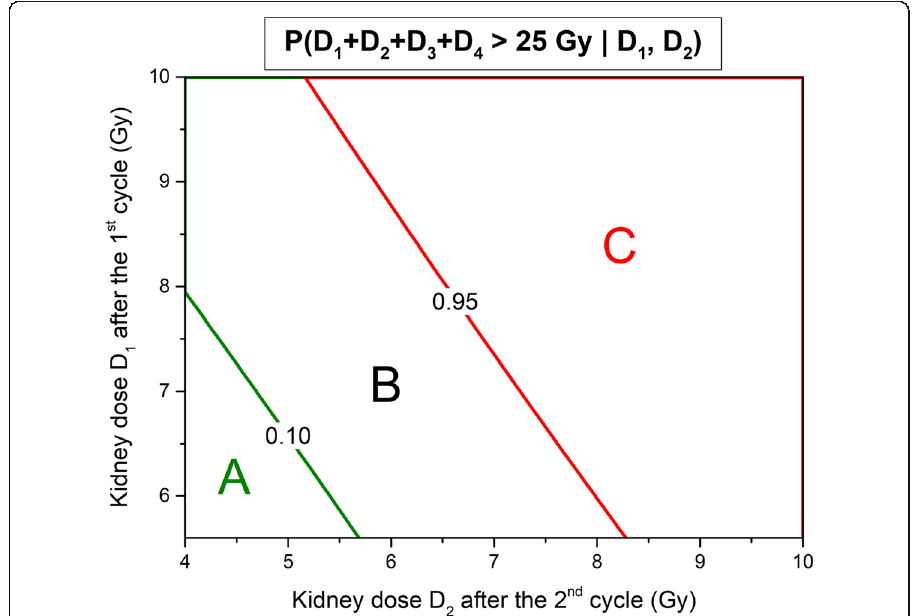
Fig. 5 Probability contour plots to exceed 25 Gy after four treatment cycles in function of D 1 , D 2 . Legend: Probability contour plots of